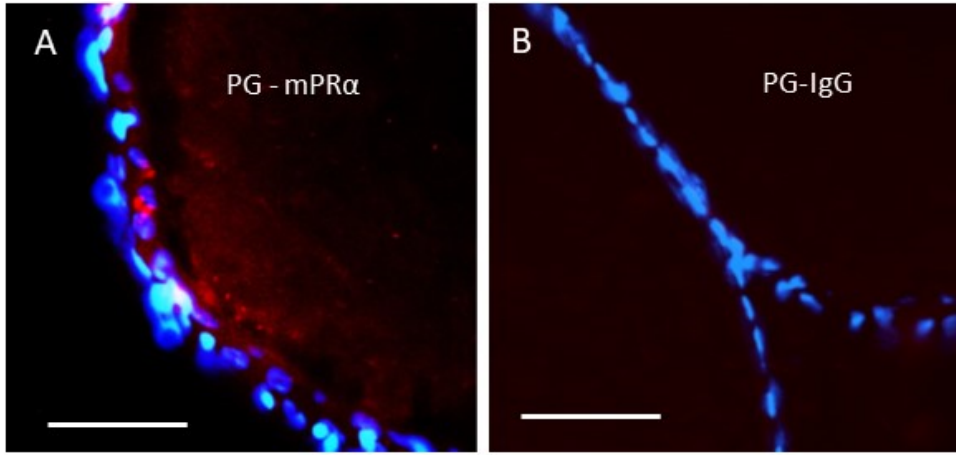
Figure 2. In situ proximity ligation analysis (PLA) of the association of mPR α with a PGRMC1 in zebrafish oocytes using zebrafish mPR α and PGRMC1 (PG) antibodies. ( A ) Close proximity of mPR α and PGRMC1 (<40 nm) in the image are shown as red dots. ( B ) PLA using the PGRMC1 antibody and IgG as a negative control showing the absence of red dots in the image. The nuclei (blue) of the follicle cells surrounding the oocyte are stained with DAPI. Scale bar 100 µm. Produced from Aizen et al. [34] with permission.